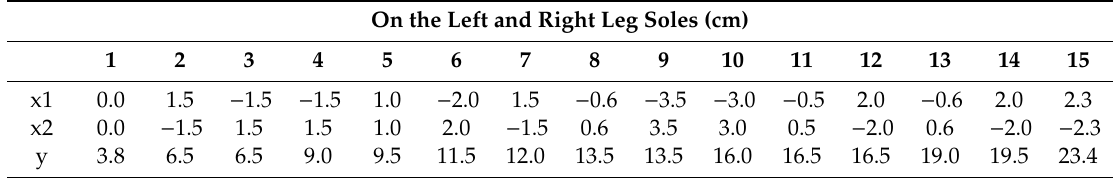
Table 1. The coordinate placement of the sensors. On the Left and Right Leg Soles (cm)